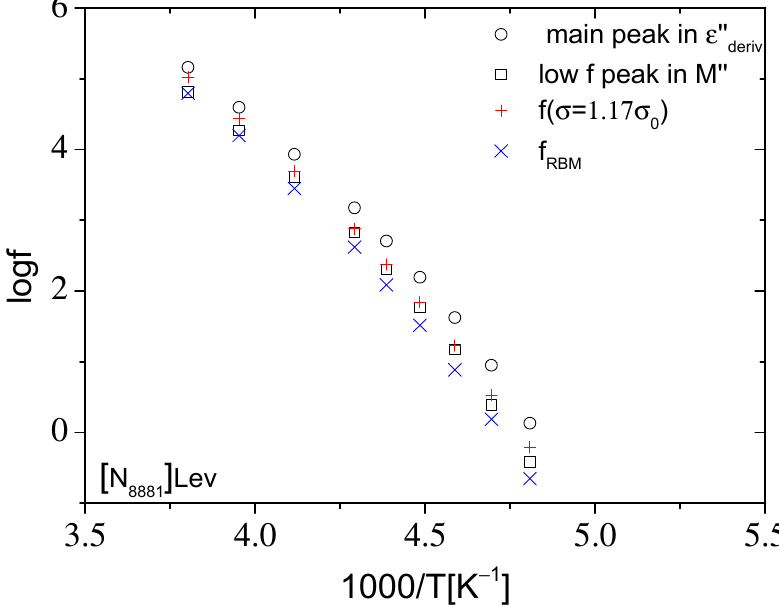
and of the deriv